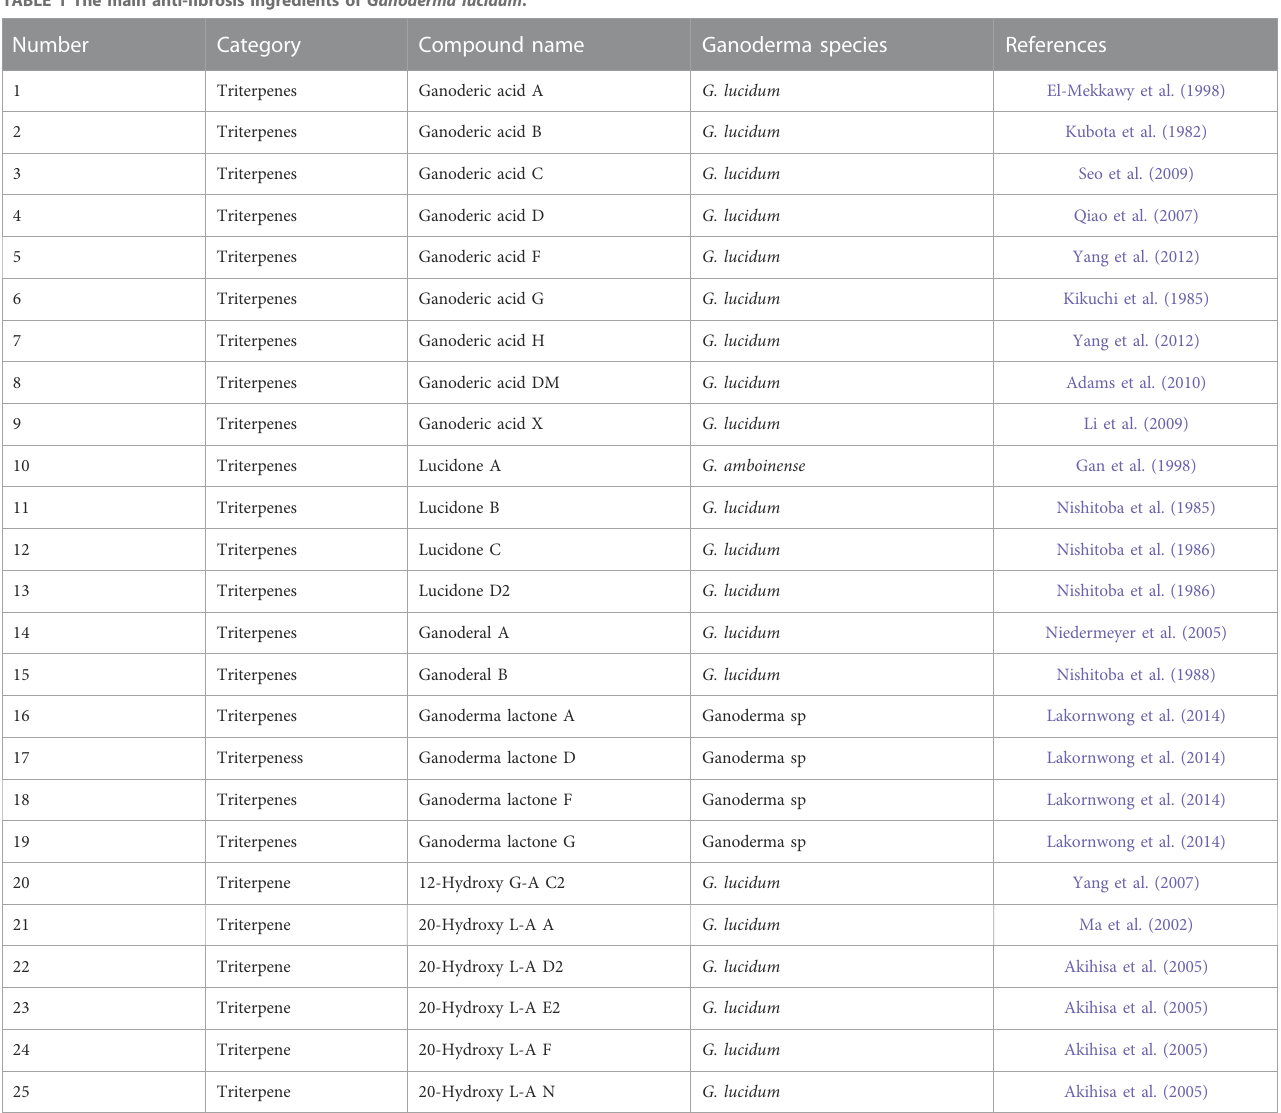
TABLE 1 The main anti- fi brosis ingredients of Ganoderma lucidum